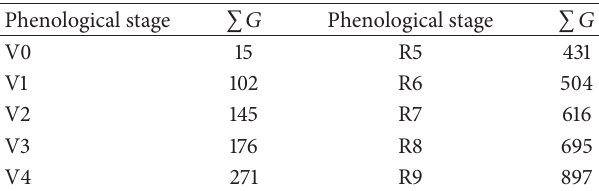
Table 1: Thermal time of bean crop phenological stages, cv. IAC